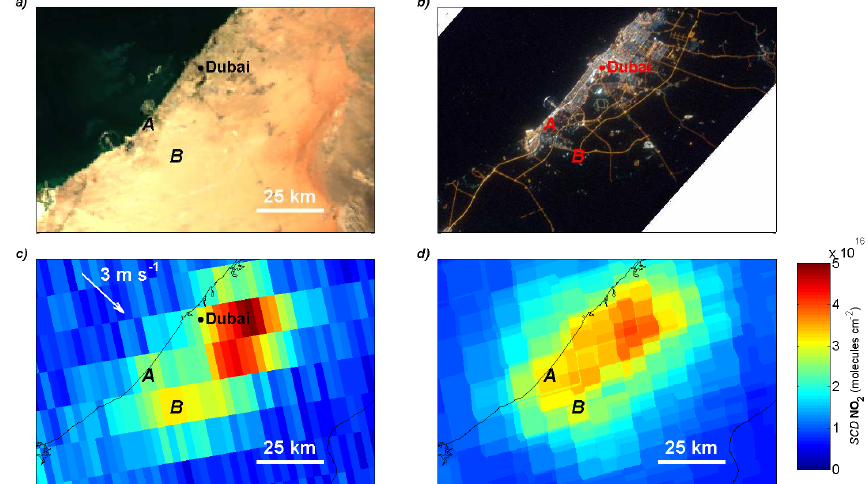
Figure 4. a) True color image from Aqua-MODIS on November 21, 2004. b) Nighttime image (courtesy of the 2 Fig. 4. (a) True color image from Aqua-MODIS on 21 November 2004. (b) Nighttime image (courtesy of the Image Science&Analysis Image Science & Analysis Laboratory, NASA Johnson Space Center, ISS020-E-39932) captured aboard the 3 Laboratory, NASA Johnson Space Center, ISS020-E-39932) captured aboard the International Space Station over Dubai, UAE, on 11 Septem- ber 2009 at 02:00a.m.LST. (c) Slant column NO 2 retrieved from a single overpass on November 21, 2004 for individual pixels and (d) a International Space Station over Dubai, UAE, on September 11, 2009 at 2 AM LST. c) Slant column NO 2 retrieved 4 six-orbit, area-weighted average of slant column NO 2 retrieved from six operational-scale orbits (Table 1). Panels (a) and (b) highlight the from a single overpass on November 21, 2004 for individual pixels and d) a six-orbit, area-weighted average of slant 5 locations of the Jebel Ali Free Zone and a point on the downwind transect. The white arrow in (c) indicates the direction and magnitude of column NO 2 retrieved from six operational-scale orbits (Table 1). Labels A, B highlight the locations of the Jebel 6 winds observed at the Sharjah and Dubai International Airports at midday on 21 November 2004 (NOAA NCDC Ali Free Zone and a point on the downwind transect. The white arrow in c indicates the direction and magnitude of 7 winds observed at the Sharjah and Dubai International Airports at midday on November 21, 2004 (NOAA NCDC 8